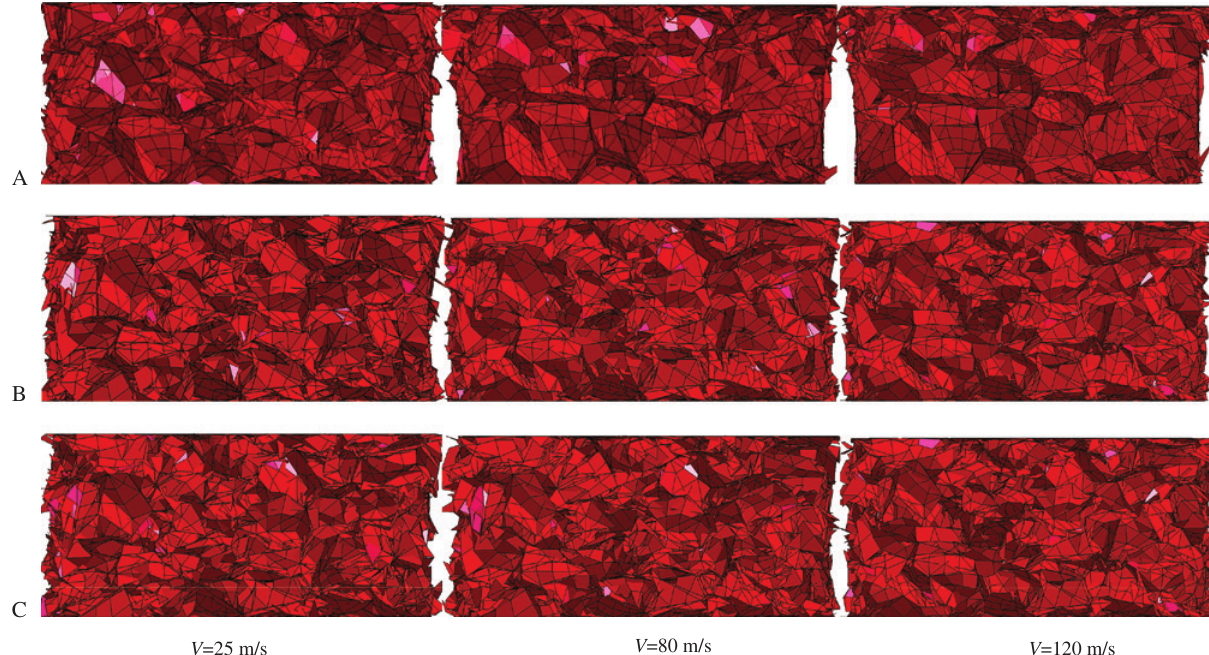
Figure 3: Deformation patterns (A, H ̅ = 0; B, H ̅ = 0.03; C, H ̅ = 0.07).